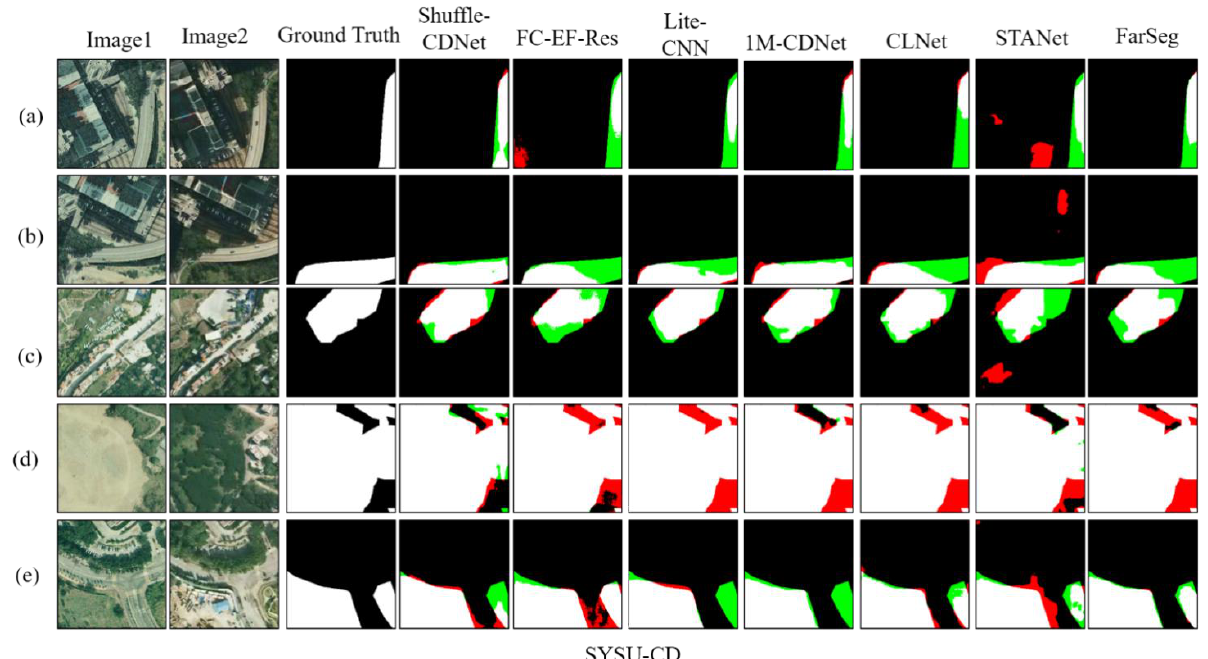
Figure 7. Results on the SYSU-CD test sets. Different colors are used for a better view, i.e., white for true positive, black for true negative, red for false positive, and green for false negative. ( a – e ) are results of five pairs of bitemporal images.